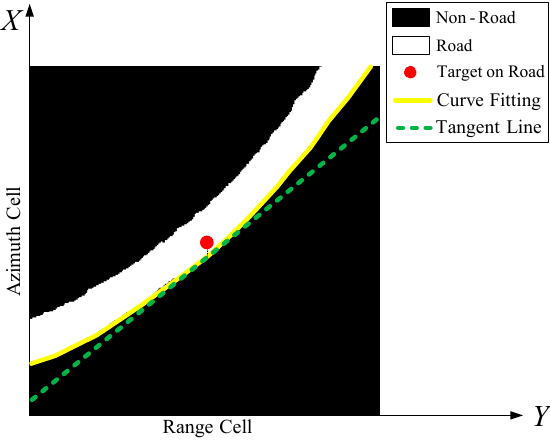
Figure 3. Road slope estimation in the square window.